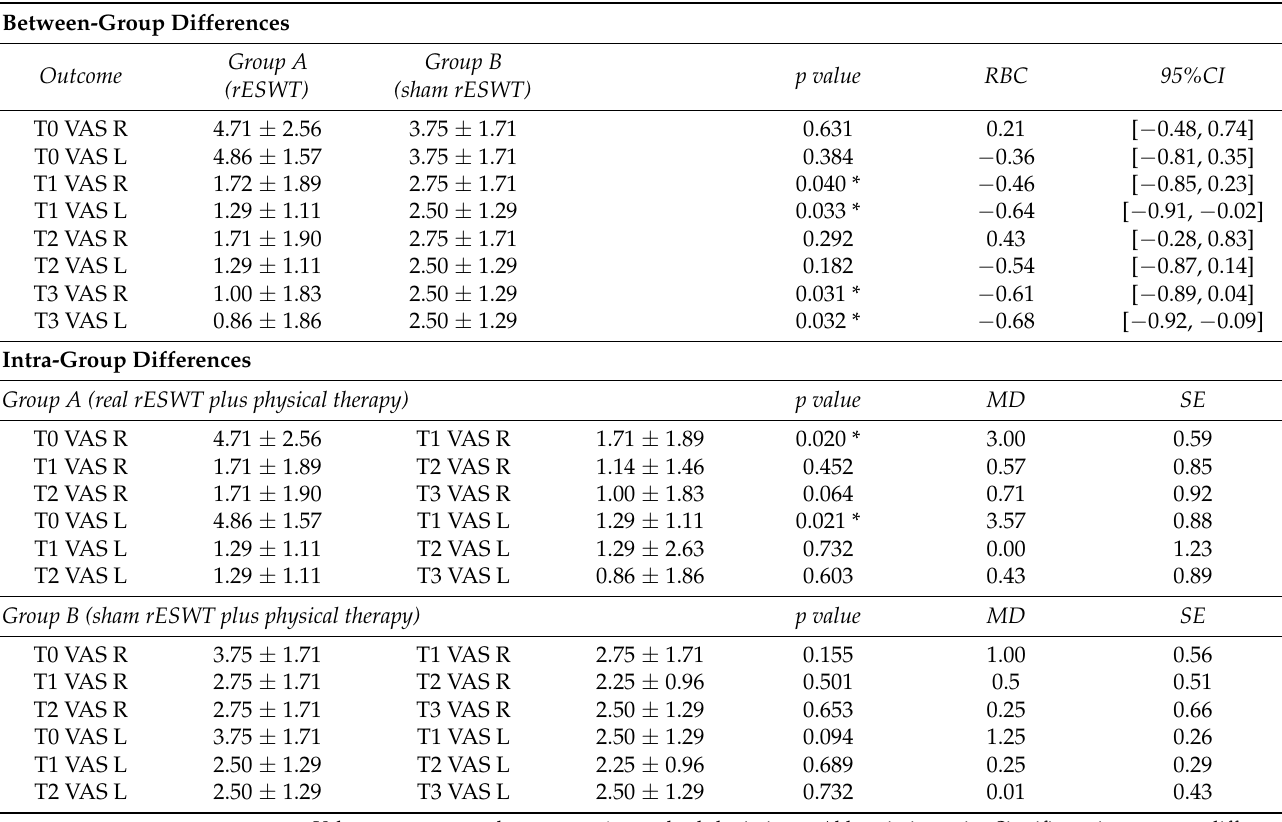
Table 2. Differences in Temporomandibular Disorder